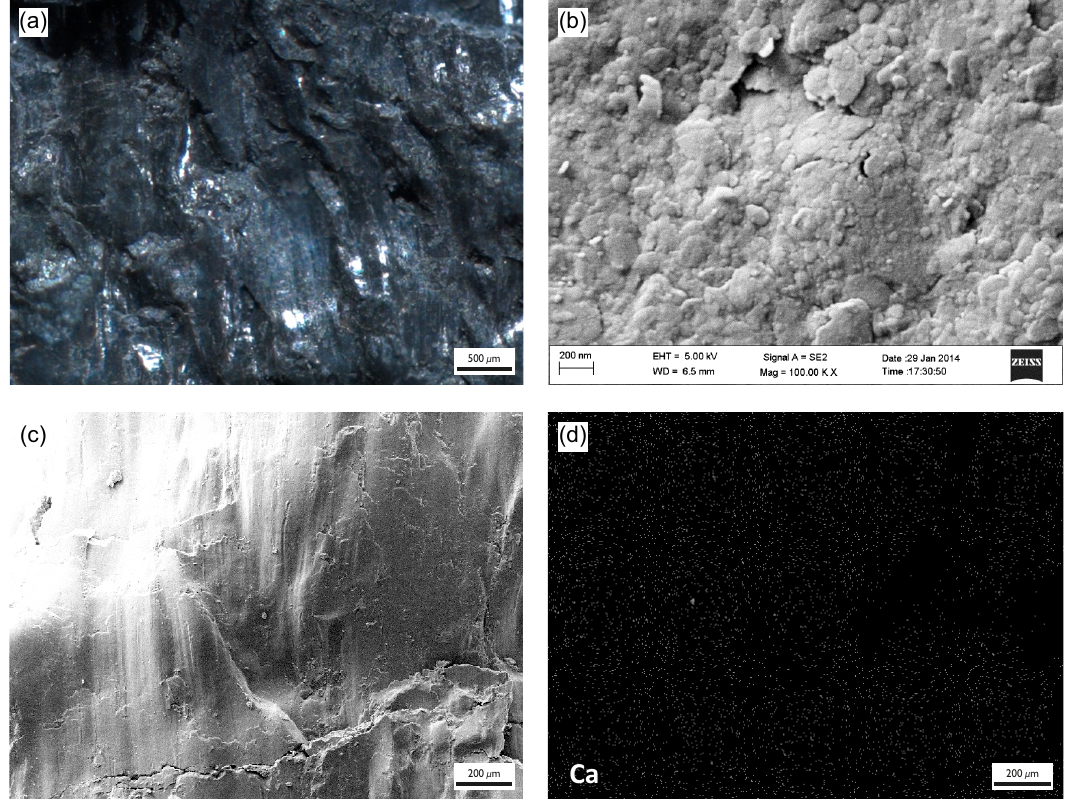
Figure 3. (a) Top view of broken shear zone surfaces (slickenside surface) in gouge (sample BPS12-4-S1). (a) Reflected light photograph and (b, c) SEM (SE) micrographs displaying nanometer-sized clay particles on a smoothly polished slickenside surface. (d) SEM-EDX Ca distribution map of panel (c) . Contrary to shear zones in the undeformed OPA, there is no Ca present, not even at slickenside